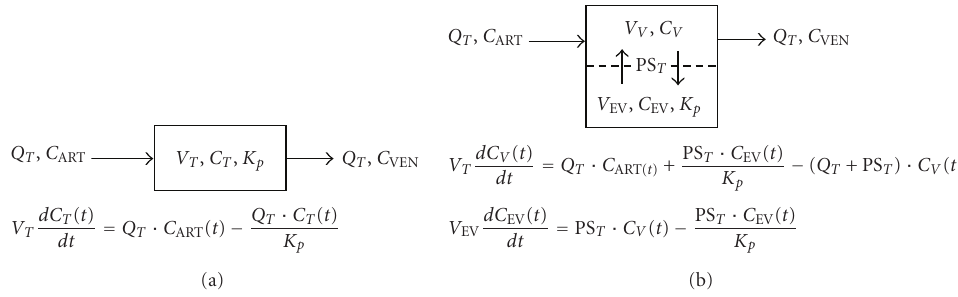
Figure 2: Diagrams and equations for a perfusion rate-limited, one-compartment model (a) and a permeability rate-limited, two- compartment model with the permeability at the vascular membrane (b) of noneliminating organs, adapted from Nestorov et al. [15]. Q = blood flow; C = concentration; V = volume; Kp = tissue:plasma distribution coe ffi cient; PS = permeability surface area coe ffi cient; subscripts T , ART, VEN, V, and EV indicate tissue, arterial, venous, vascular compartment, and extravascular compartment,